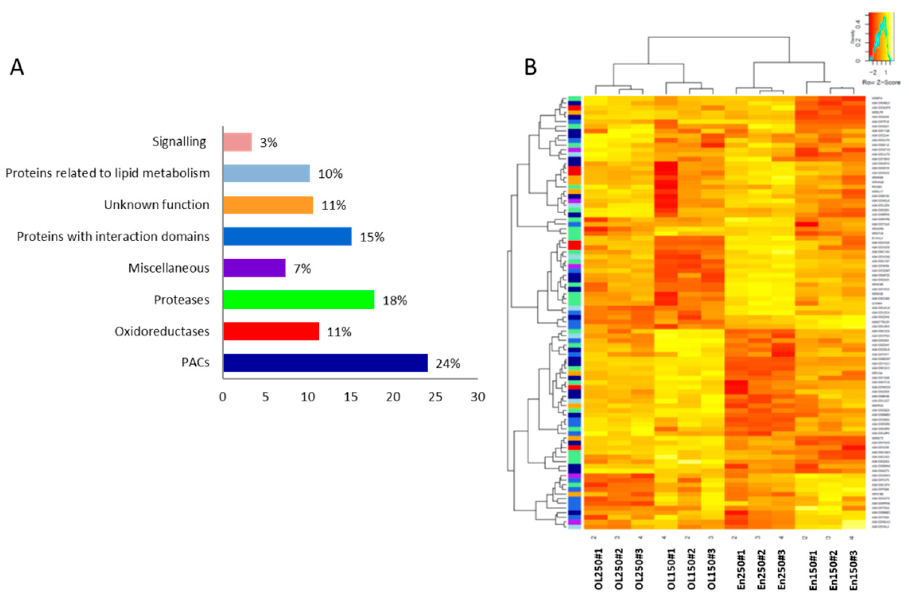
Figure 4. Distribution of CWPs and variation of their abundance according to the different conditions. ( A ) Distribution of CWPs into functional classes according to their predicted functions. PACs: proteins acting on cell wall polysaccharides. ( B ) Heatmap of the relative amounts of CWPs identified in the four conditions (in the endosperm (EN), in the outer layers (OL), and at 150 and 250 GDD).